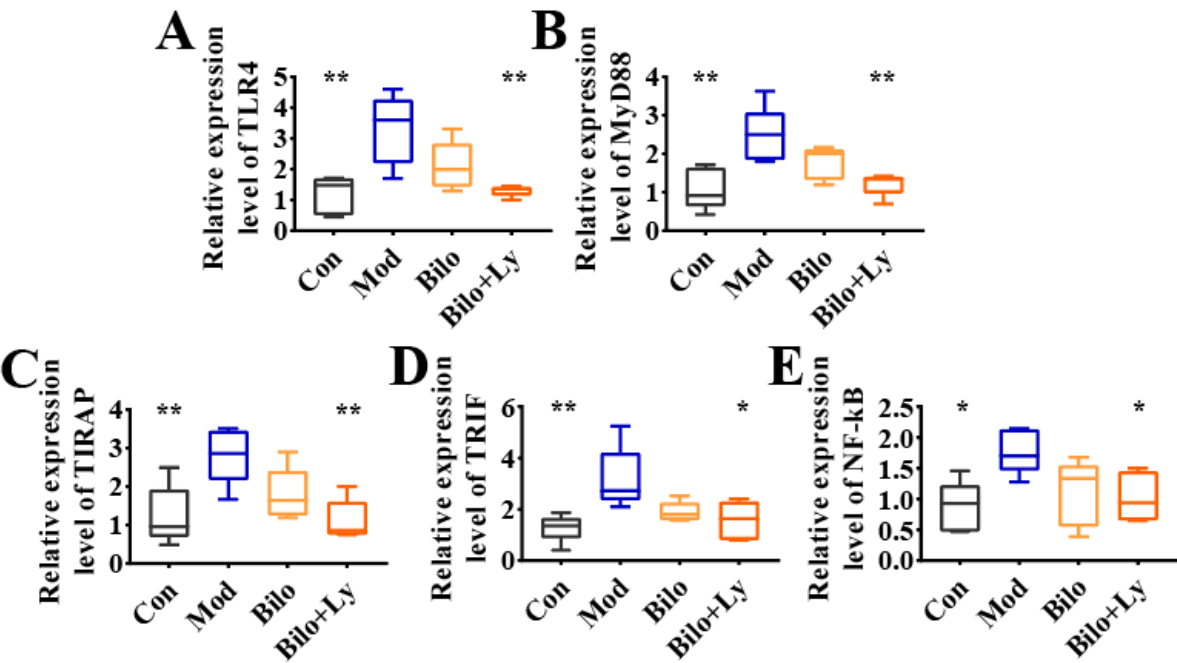
Figure 4. Effect of lycopene on gene expression levels of TLR4/MyD88 pathway. The expression level of TLR4 mRNA in mouse kidney ( A ). The expression level of MyD88 mRNA in mouse kidney ( B ). The expression level of TIRAP mRNA in mouse kidney ( C ). The expression level of TRIF mRNA in mouse kidney ( D ). Expression levels of NF-kB mRNA in mouse kidneys ( E ). TLR4 pathway effect map. Signs of significant differences between the Mod group and other groups: * p < 0.05, ** p < 0.01.